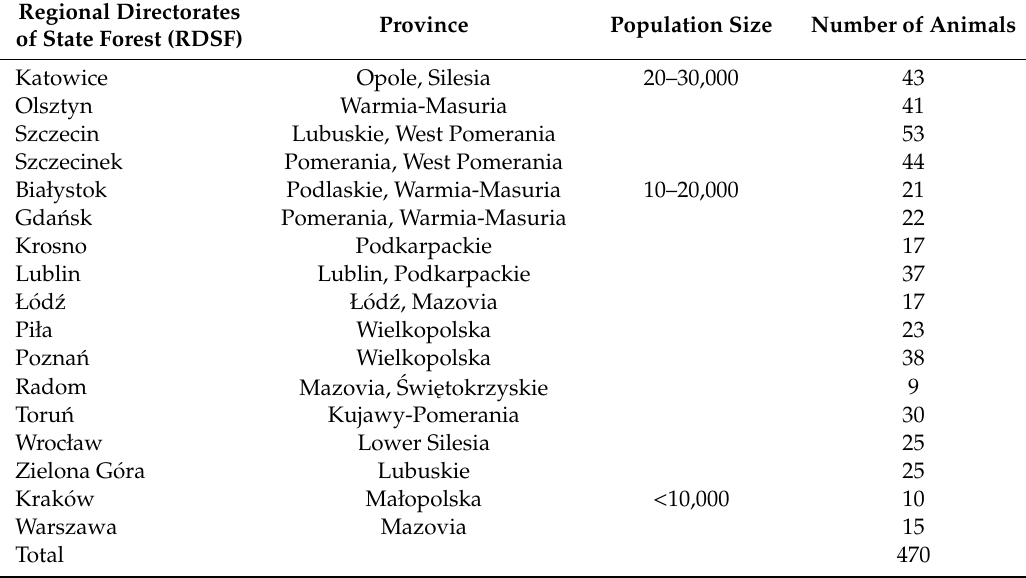
Table 1. The population size of wild boars, their inhabiting area and the number of tested